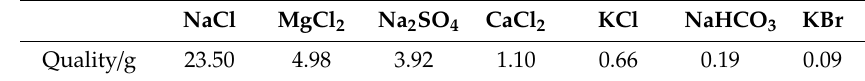
Table 2. Synthetic components of simulated